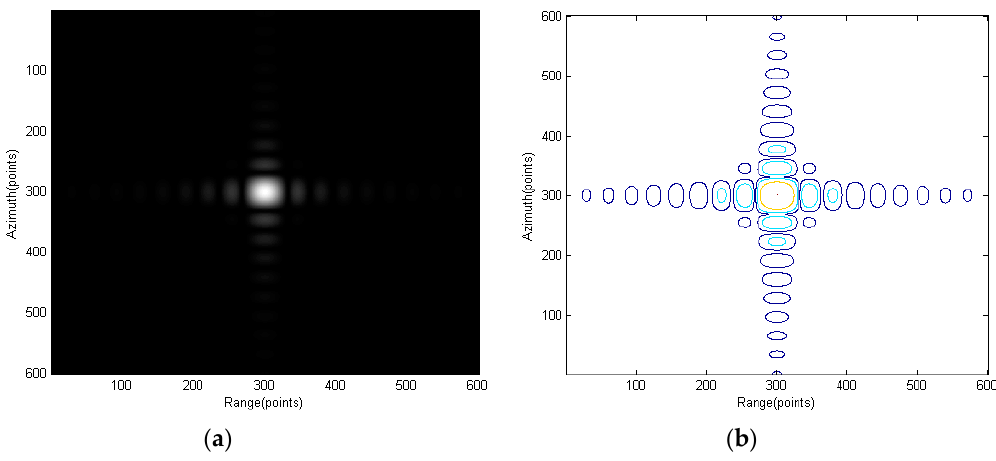
Figure 7. Point E: ( a ) amplitude plot and ( b ) contour plot.